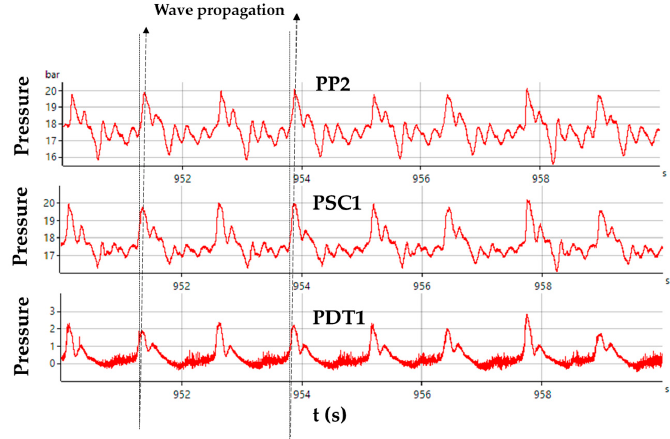
Figure 16. Time signal of the pressure in the draft tube (PDT1), in the spiral casing (PSC1) and in the penstock (PP2) during the overload instability.